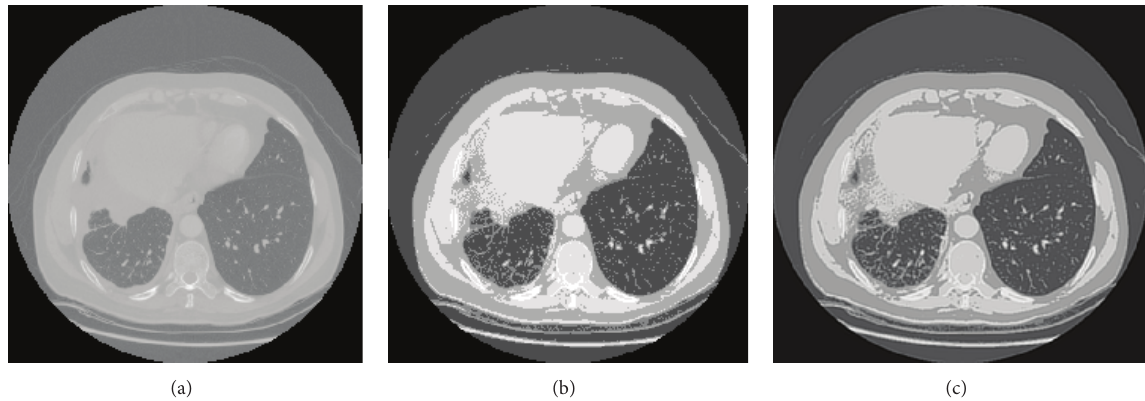
Figure 1: (a) The lung CT image; (b) the histogram equalized image; (c) the Weiner filtered output